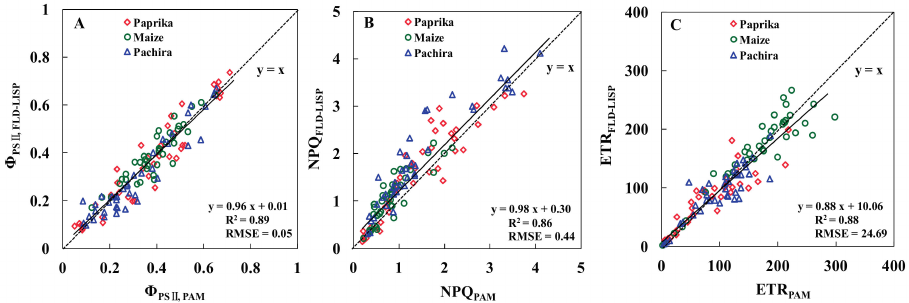
Figure 7. Relationships between the ChlF parameters estimated by the two methods (PAM and FLD-LISP) ( A ) Φ PSII ; ( B ) NPQ; and ( C ) ETR. The diamonds, circles, and triangles represent the results of paprika, maize, and pachira, respectively. R 2 and RMSE of all samples are shown in the figures and